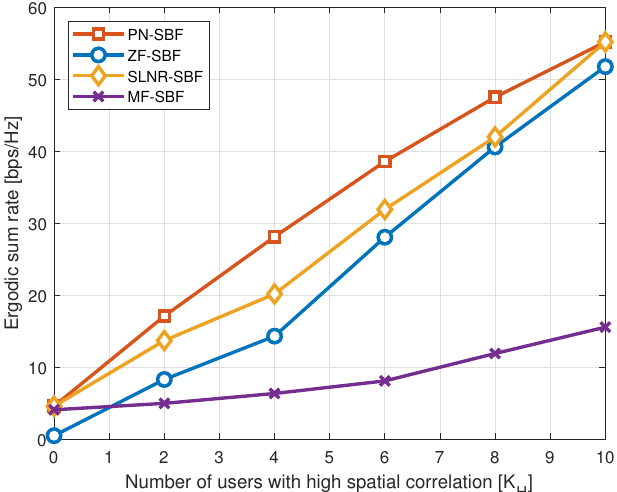
Figure 4. Ergodic sum rate as a function of K H , where M = 128, ρ = 10 dB, ∆ H = 10 ◦ , ∆ L = 60 ◦ , K = 10, and K L = K − K H